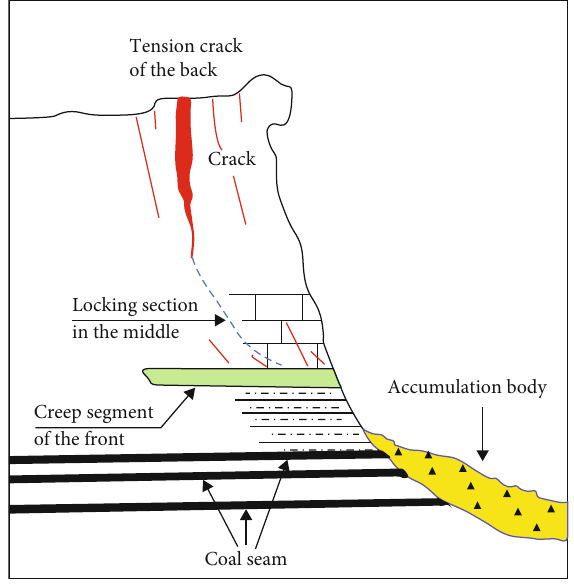
Figure 9: The three-section mechanism of a landslide